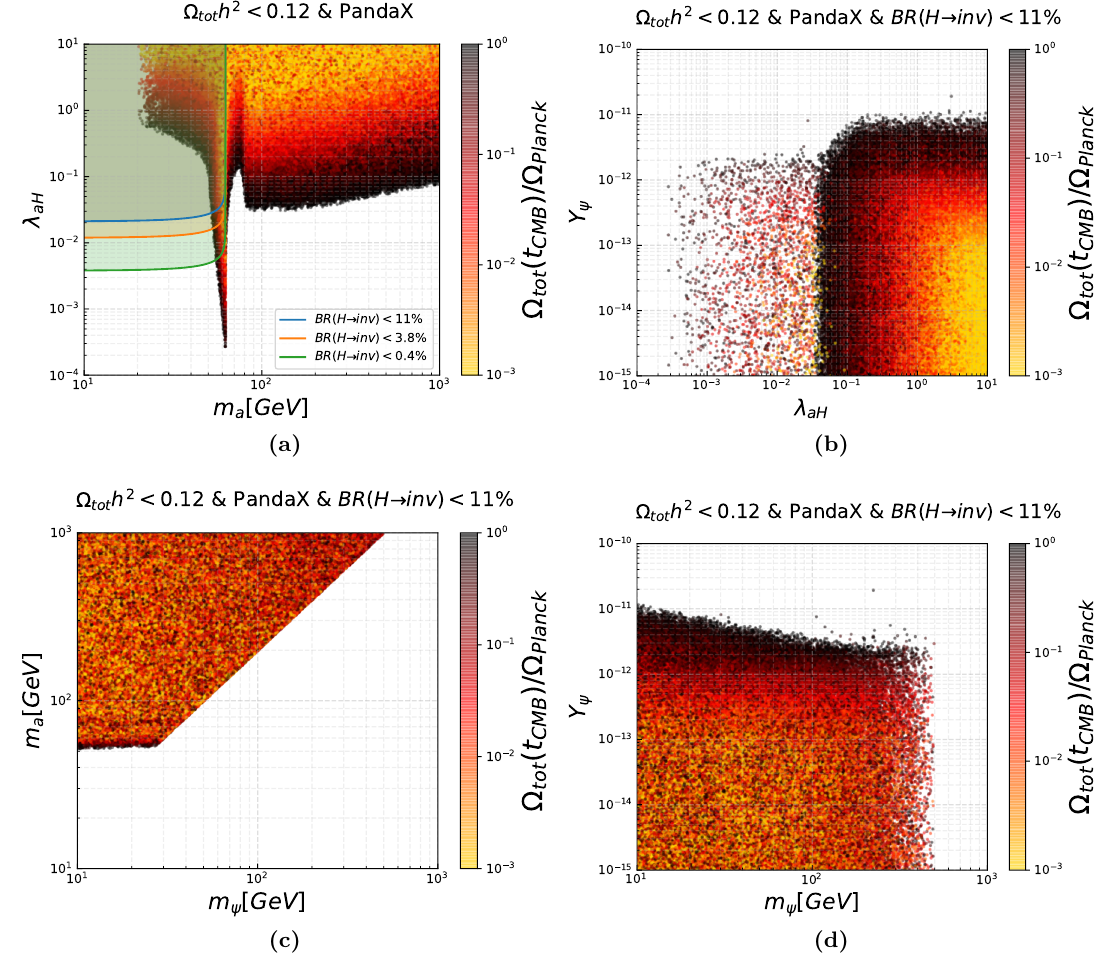
˜ (CP-odd) model with F 0 S 0 0 0 Ω ), ψ a / PLANCK